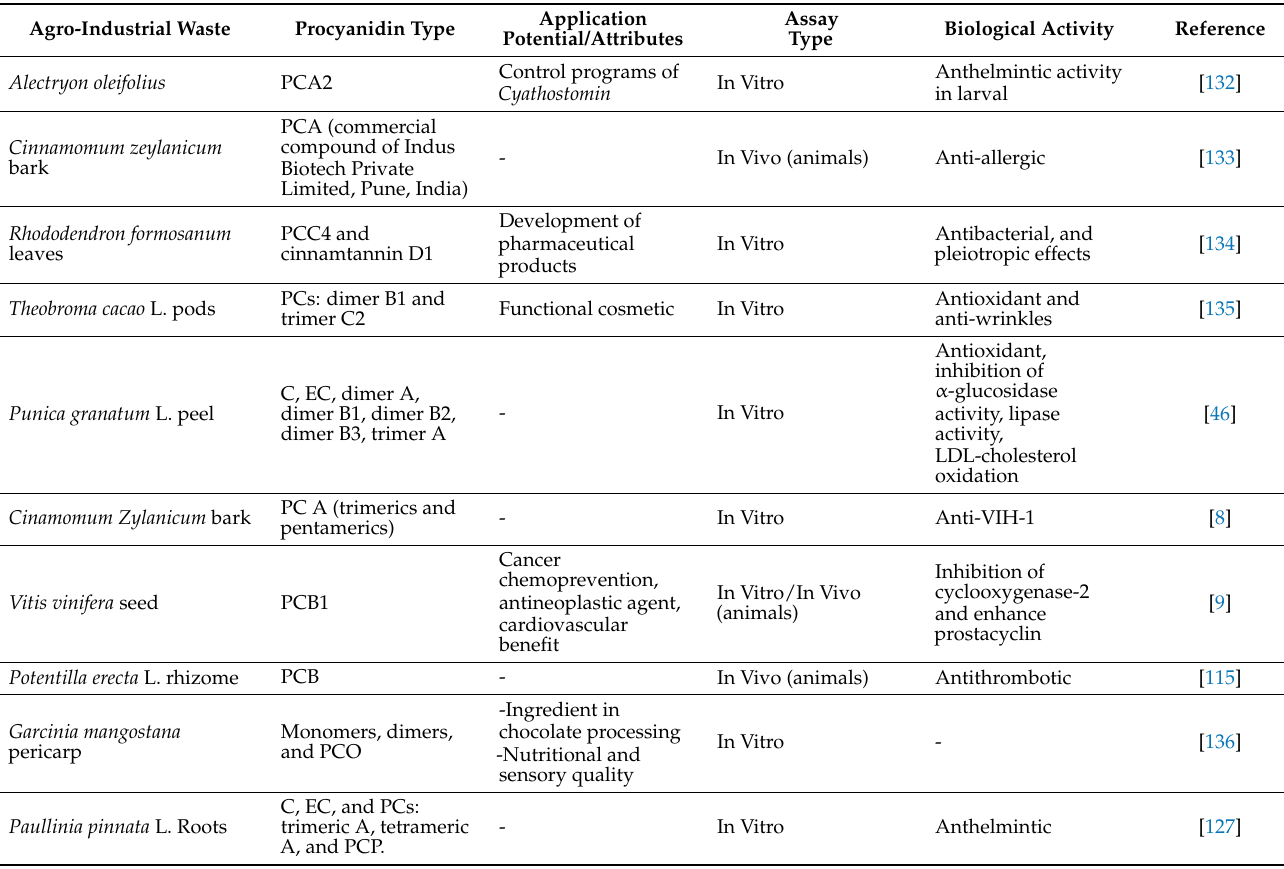
Table 2. Biological activity of procyanidins obtained from agro-industrial wastes, and possible applications. Agro-Industrial